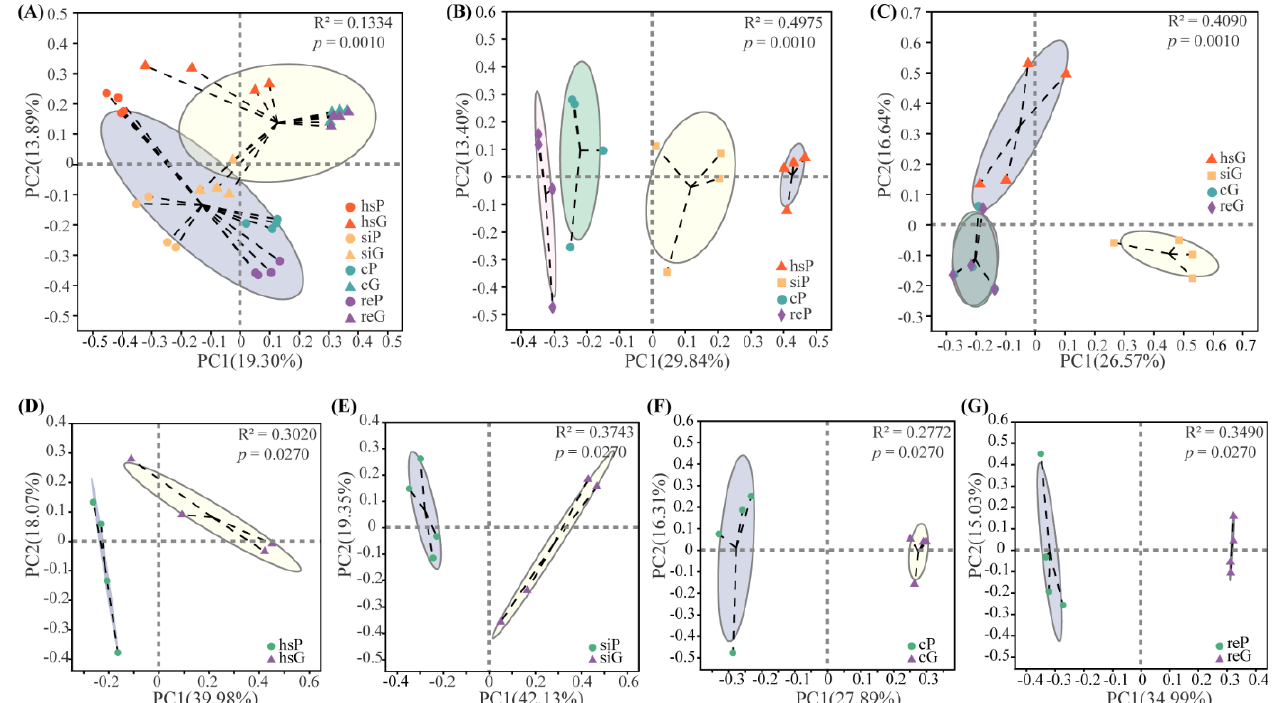
Figure 3. Bray–Curtis distance–based principal coordinate analysis (PCoA). P represents the plateau zokor and G represents the Gansu zokor. The bacterial community of the stomach, small intestine, cecum, and rectum of the plateau zokor (the Gansu zokor) are labeled as hsP, siP, cP and reP (hsG, siG, cG and reG). ( A ) PCoA analysis of the whole GITs of plateau and Gansu zokors. ( B ) PCoA analysis of different GIT segments of plateau zokors. ( C ) PCoA analysis of different GIT segments of Gansu zokors. ( D ) PCoA analysis of hsP vs hsG. ( E ) PCoA analysis of siP vs siG. ( F ) PCoA analysis of cP vs cG. ( G ) PCoA analysis of reP vs reG.